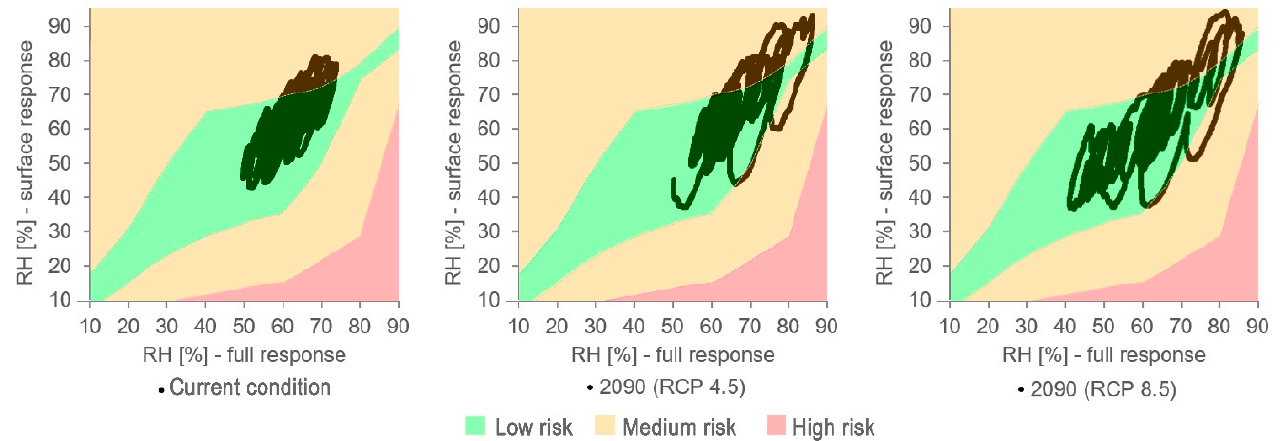
Figure 16. Risks associated with mechanical deterioration on painted wood panels for climate change scenarios.